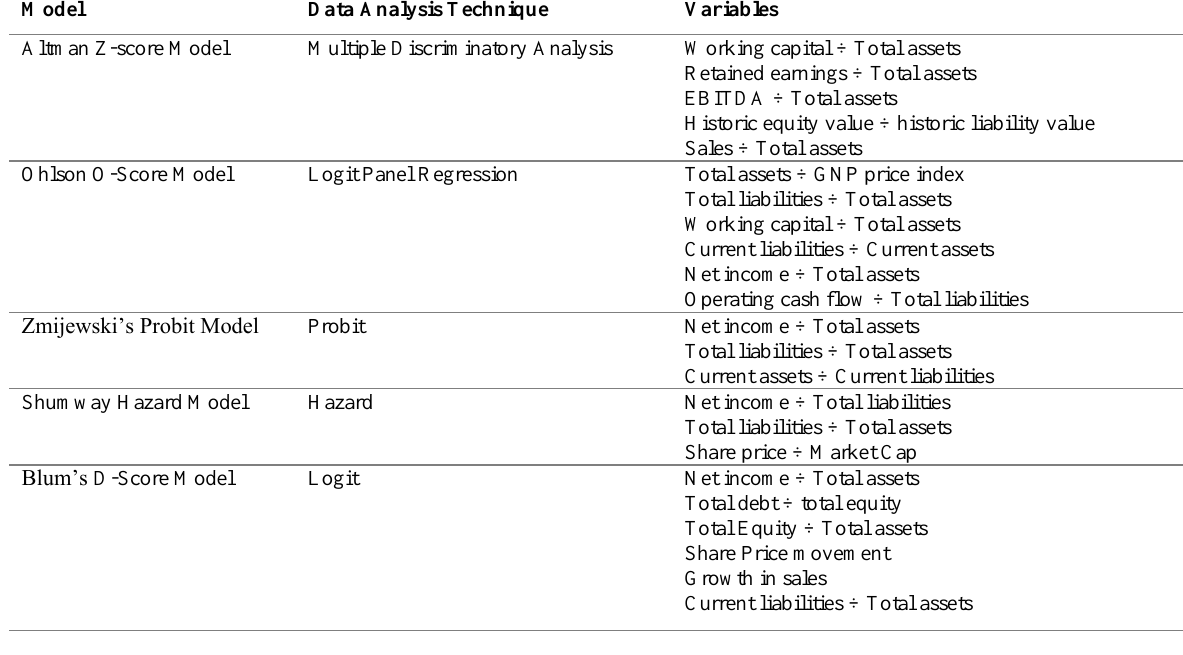
Table 1: Empirical Models of Financial